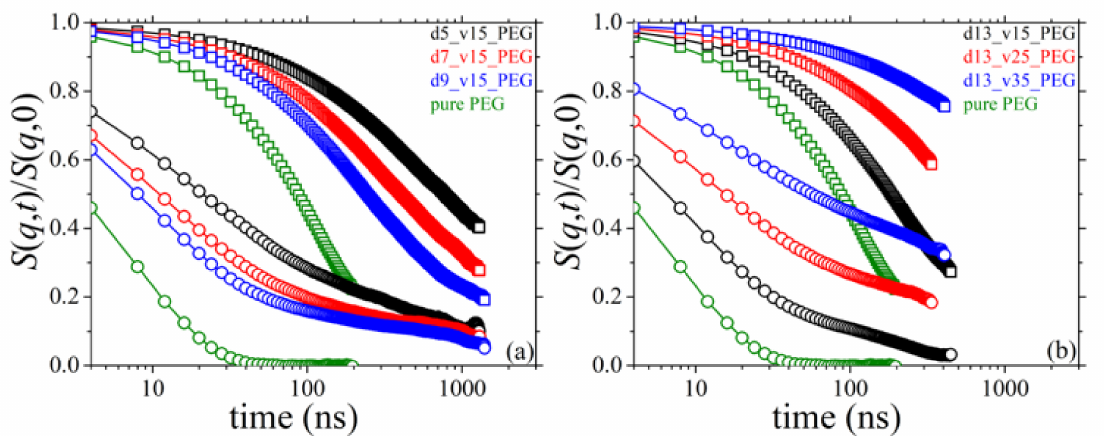
Figure 14. MD-predicted S ( q , t )/ S ( q ,0)-vs.- t spectra ( T = 413 K and p = 1 atm) and dependence on: ( a ) silica size, and ( b ) silica concentration. Results are shown for q = 0.04 Å − 1 (open squares) and q = 0.15 Å − 1 (open